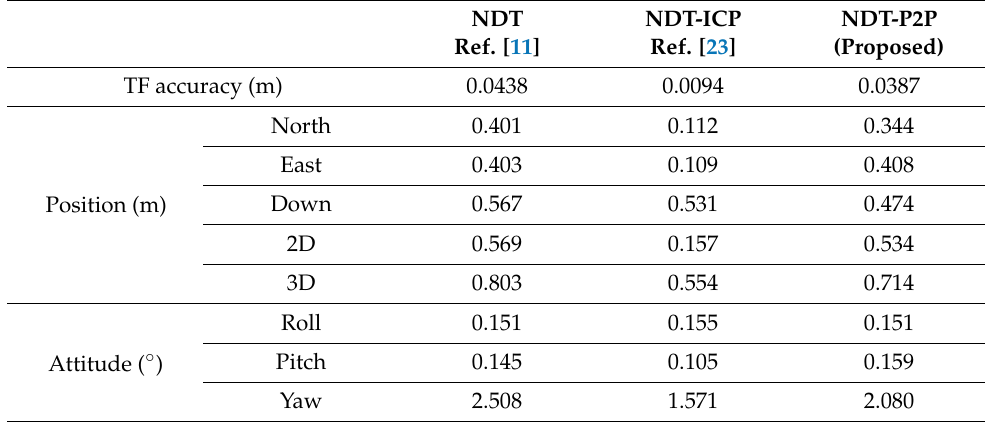
Figure 7. The errors of the estimated position and attitude. Table 2. Transformation accuracy and RMSE for Figure